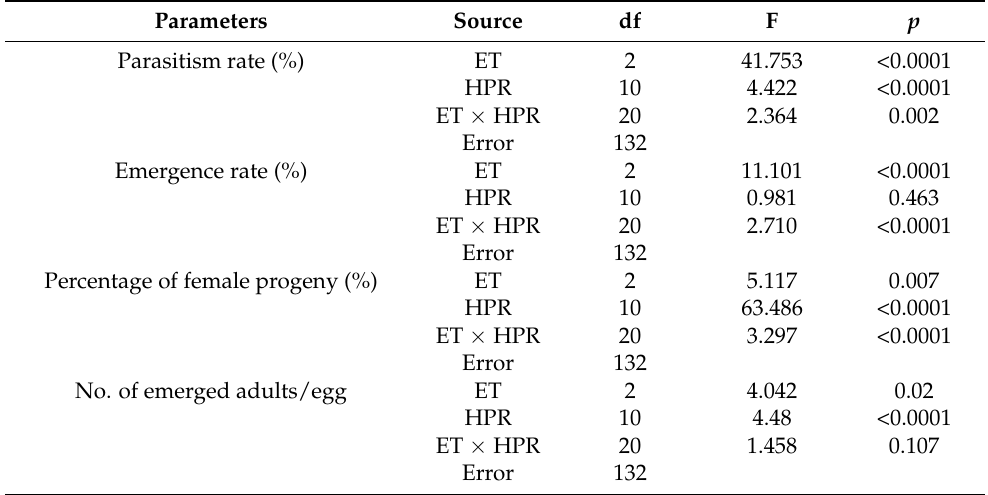
Table 2. Results from ANOVA analysis on the effects of exposure time, host egg:parasitoid ratio, and their interactions on the biological parameters of T. remus on S. litura eggs.